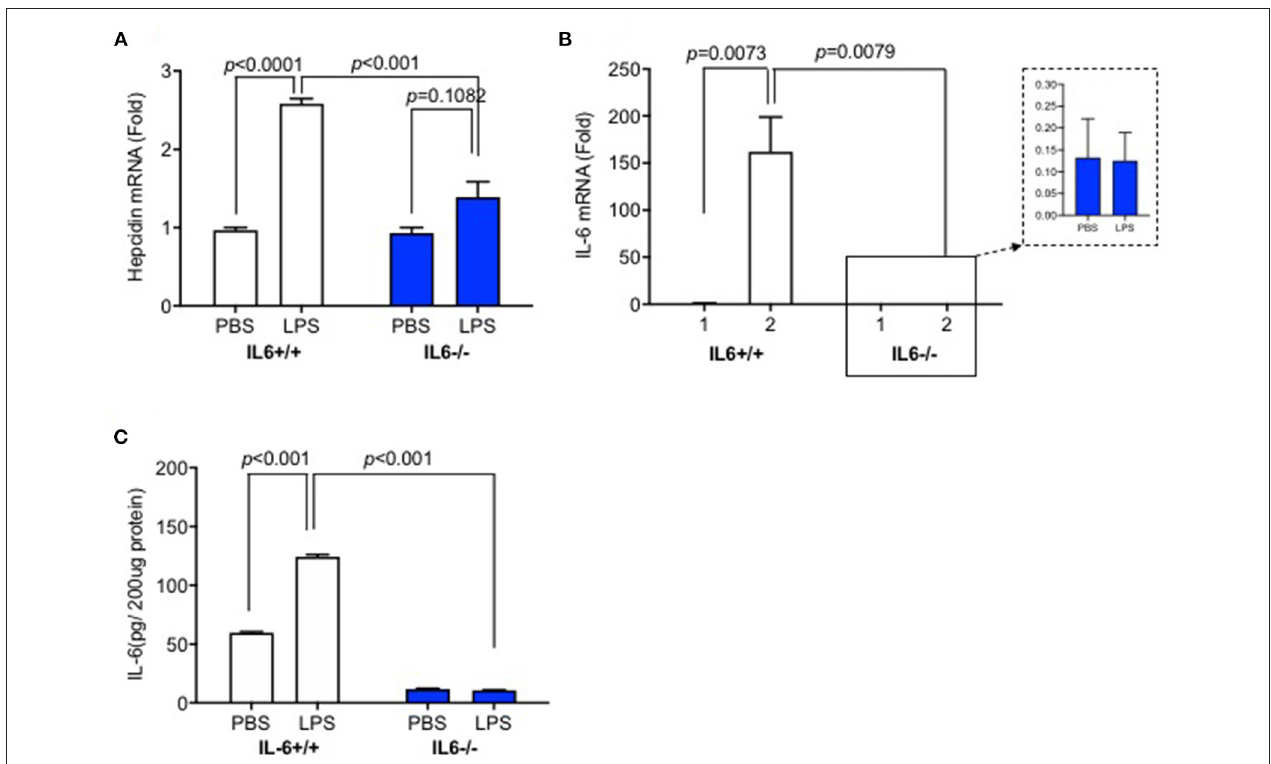
FIGURE 1 | Hepcidin mRNA, IL-6 mRNA, and protein expression in the liver of IL-6–/– mice were significantly lower than those in IL-6 + / + mice after lipopolysaccharide (LPS) administration. IL-6 + / + and IL6–/– mice received intracerebroventricular (ICV) injection of LPS (5 µ g). After 6h, the expression of hepcidin mRNA (A) and IL-6 mRNA (B) was detected using RT-PCR, and IL-6 protein expression (C) was measured using ELISA. Data are expressed as the means ± SEM (% control) (IL-6 + / + : PBS = 4, LPS = 6; IL-6–/–: PBS = 3, LPS = 4). Analysis between the treatments was done via two-way ANOVA with Sidak’s post hoc test.